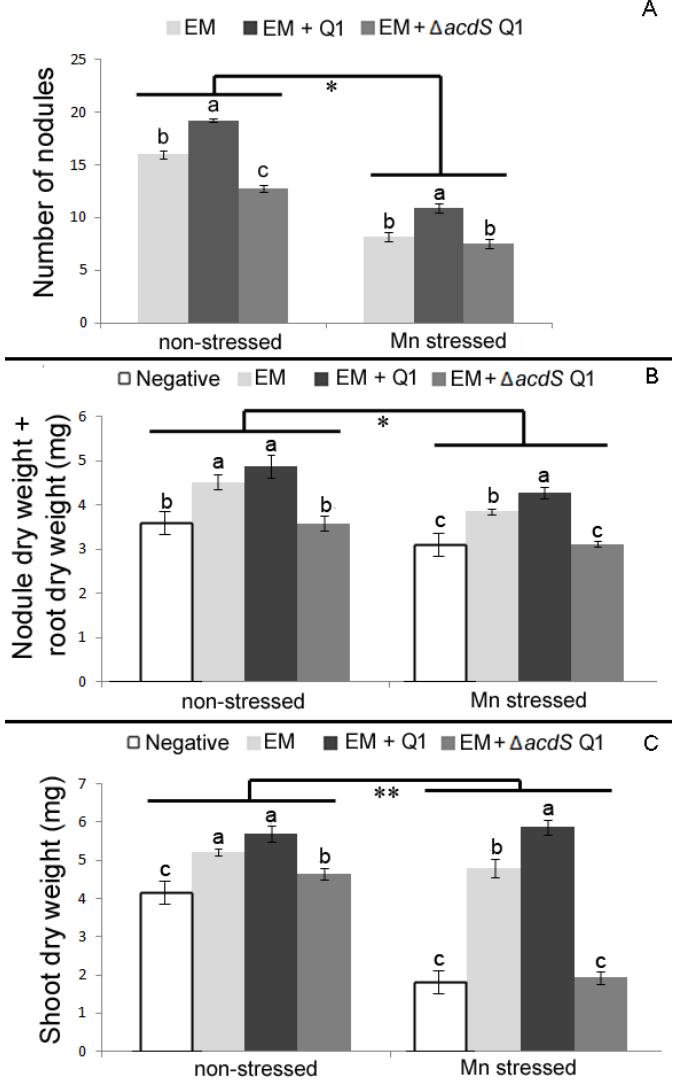
Figure 6. Effects of single inoculation ( E. meliloti ATCC9930 T (EM)) and co-inoculation ( E. meliloti + Q1) or E. meliloti ATCC9930 T and Pseudomonas sp. Q1 ∆ acdS ATCC9930 T and Pseudomonas sp . Q1 (EM + Q1) or E. meliloti ATCC9930 T and Pseudomonas sp . Q1 Δ acdS ATCC9930 T and Pseudomonas sp. Q1 (EM (EM + ∆ acdS Q1) on burr medic plants grown in a vermiculite pot assay for 42 days. ( A ) Number